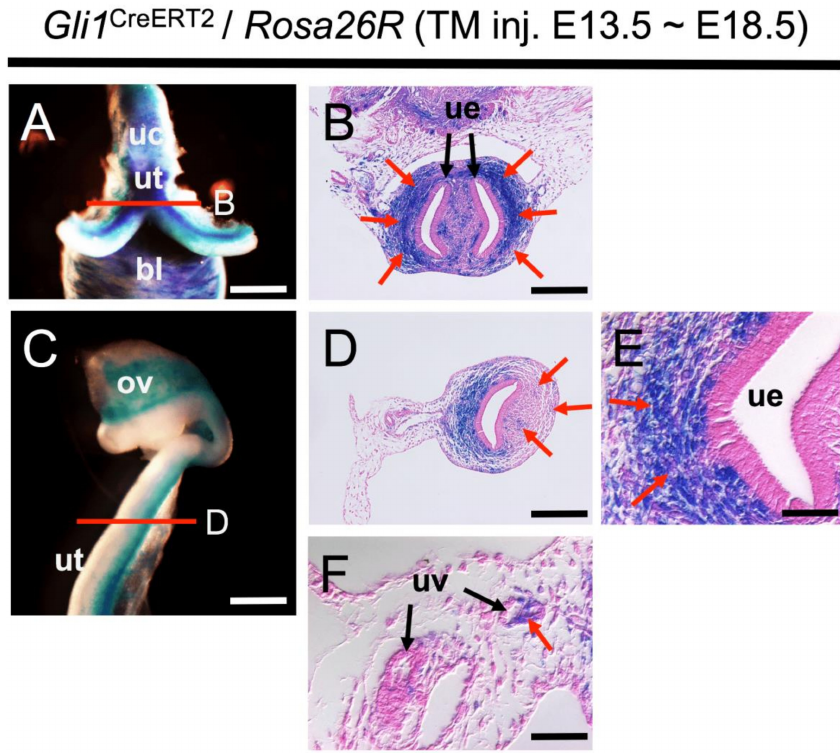
Figure 4. Developmental contribution of Hh-signal-responsive cells in the Wolffian region to embryonic uterus. ( A – F ) Whole-mount and section images of X-gal-stained Gli1 CreERT2 ; Rosa26 -LacZ female specimens at E18.5. Red lines in ( A ) and ( C ) indicate sites of transverse sections in ( B , D ). ( E , F ) Higher magnification of the uterine epithelium and uterine vessels on the mesometrial side. ( B , D – F ) TM administration at E13.5, β -galactosidase activity (red arrows) showing Hedgehog- responsiveness is mainly observed in mesenchymal cells surrounding the mesometrial side of uterine epithelia at E18.5. A few LacZ-positive cells are observed in the antimesometrial side ( D , red arrows). These results were observed in several individuals ( n = 3). bl, bladder; ov, ovary; uv, uterine vessel; uc; uterine cervix; ue, uterine epithelia; ut, uterus. Scale bars indicate 500 µ m ( A ), 200 µ m ( C ), 100 µ m ( B , D ), and 50 µ m ( E , F